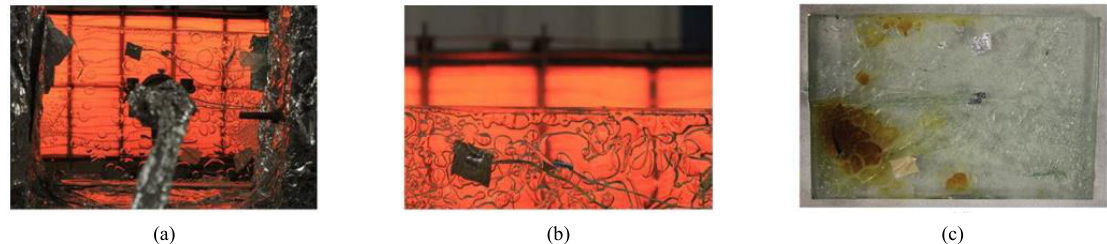
Fig. 13 Reaction of the interlayer material for configuration 6106.4 PVB: (a) gas formation in the interlayer closest to the exposure, (b) the interlayer starts liquefying and (c) the discoloured interlayers after exposure (Debuyser et al.